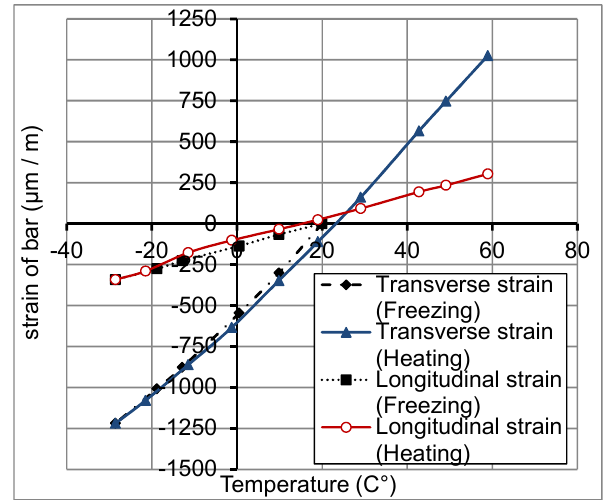
Figure 8. Behavior of GFRP imbedded in concrete of the slab SA.200.30.16 under cooling-heating cycle and sustained load.